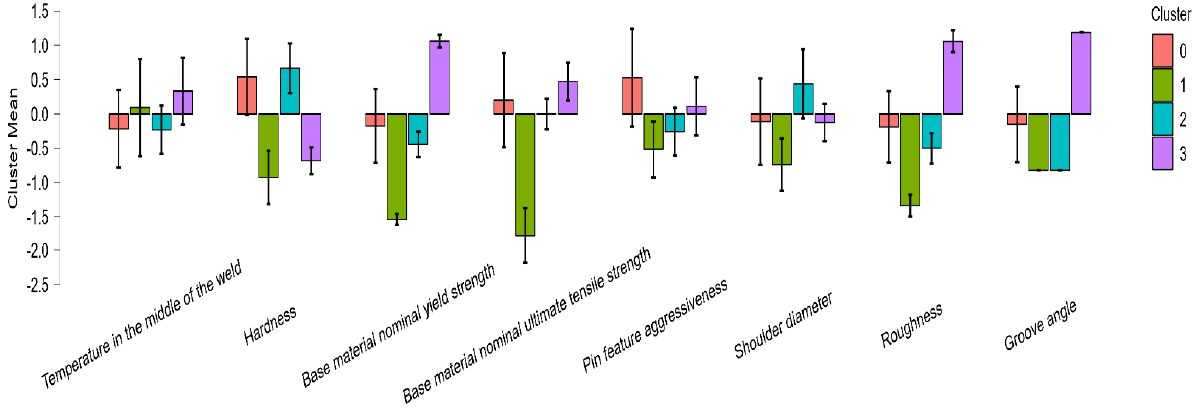
Figure 3. The clustering coefficient and features of the welded joint